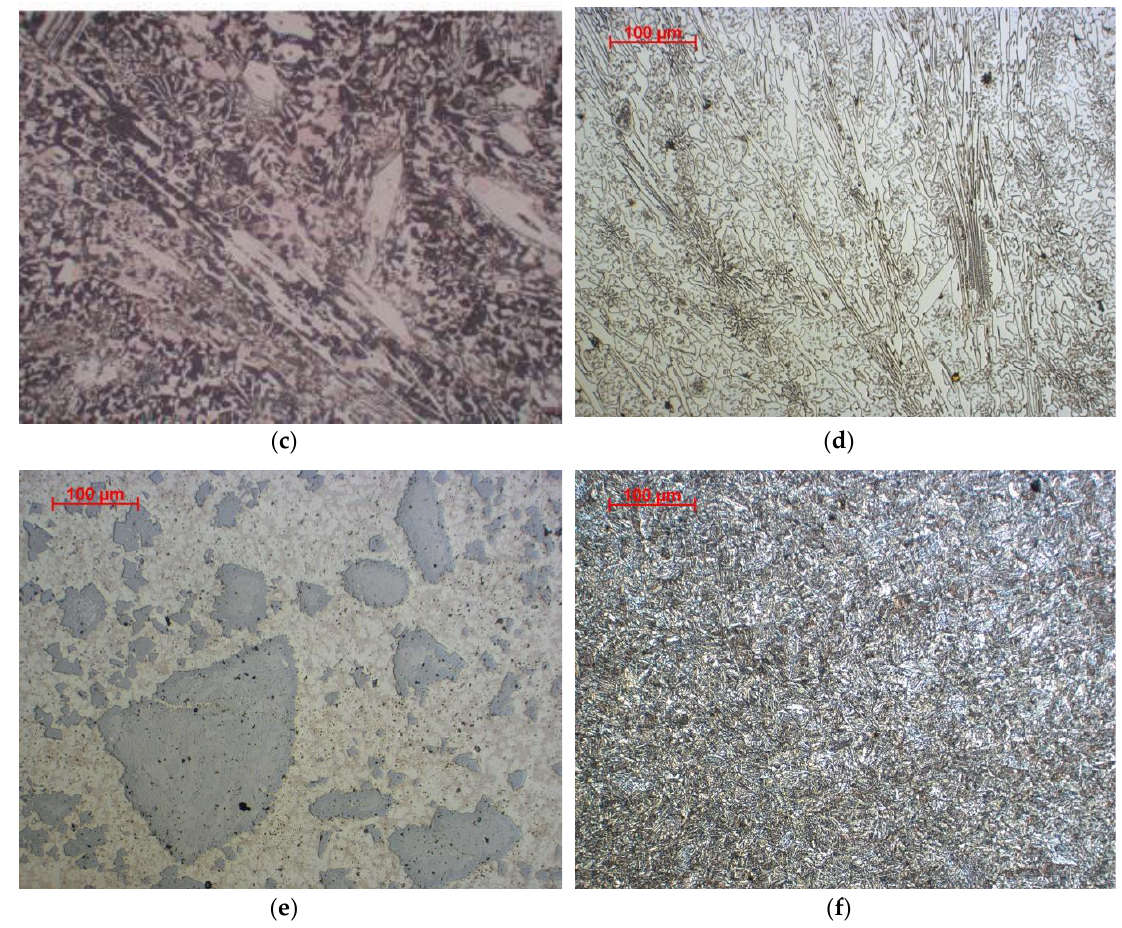
Figure 7. Microstructure of layers resistant to abrasive wear. ( a ) NANO; ( b ) ABRECOPLATE; ( c ) CDP; ( d ) ABRADUR 64; ( e ) WC; ( f ) HARDOX 400; Reagents selected for abrasion resistant material.